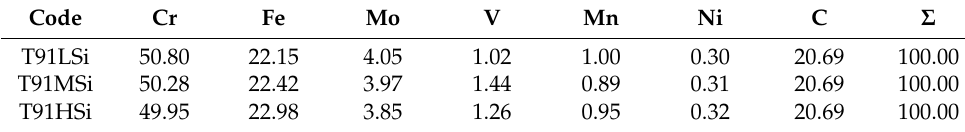
Table 3. Amount proportion in M 23 C 6 phase (at.%).